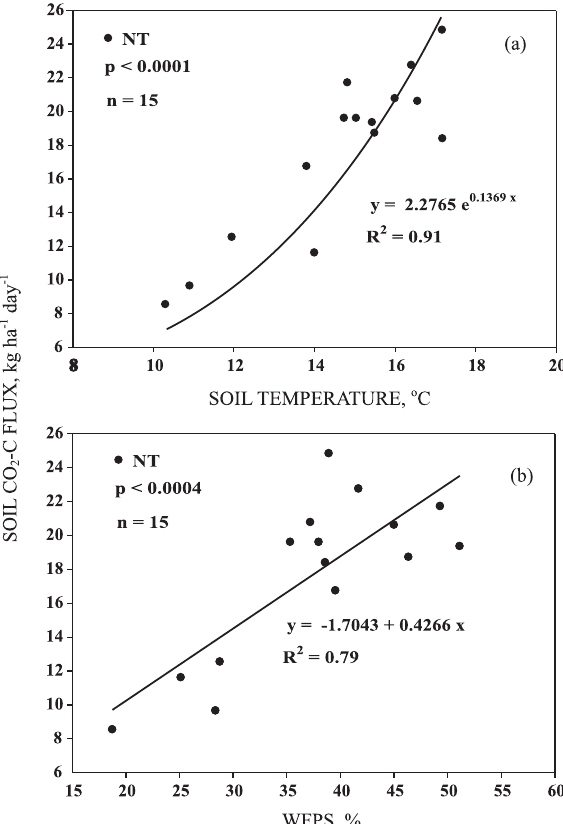
Figure 4. Relationship between CO temperature in the 0-0.10 m layer (a) and water- filled pore space (WFPS) in the 0-0.10 m layer (b) measured in a dynamic chamber in no-tillage system (NT).